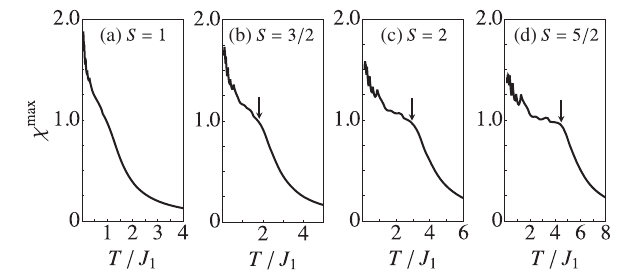
FIG. 13. For the isotropic nearest-neighbor Heisenberg anti- ferromagnet, we show, for different values of the spin S , the RG flow of the susceptibility tracked at the dominant wave